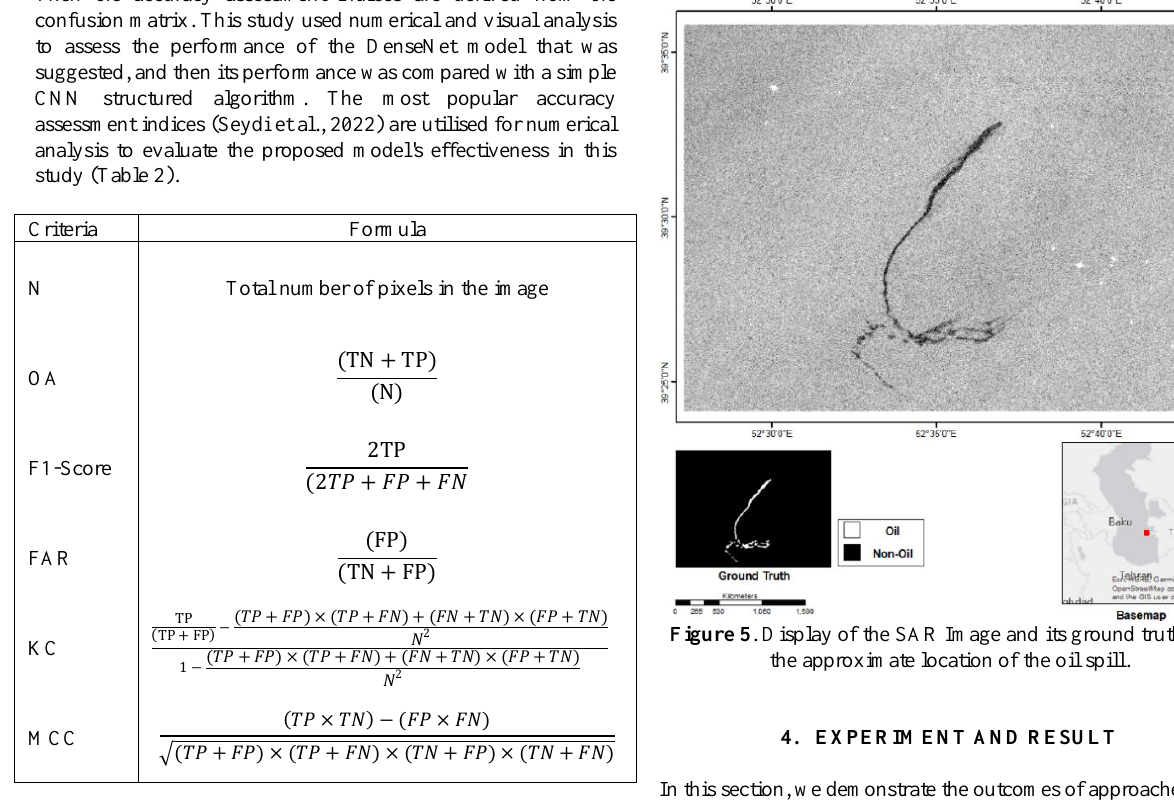
Table 2 . The accuracy assessment indices.